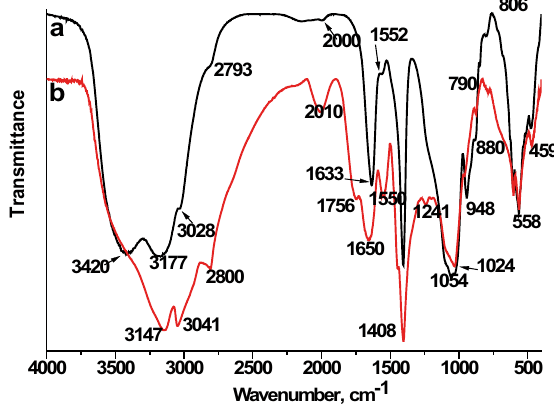
Figure 4. FTIR spectra of collagen/silicocarnotite coatings, before immersion in 1.5SBF with different quantity of collagen and silicocarnotite: 25:75 wt% (a) and 75:25 wt%